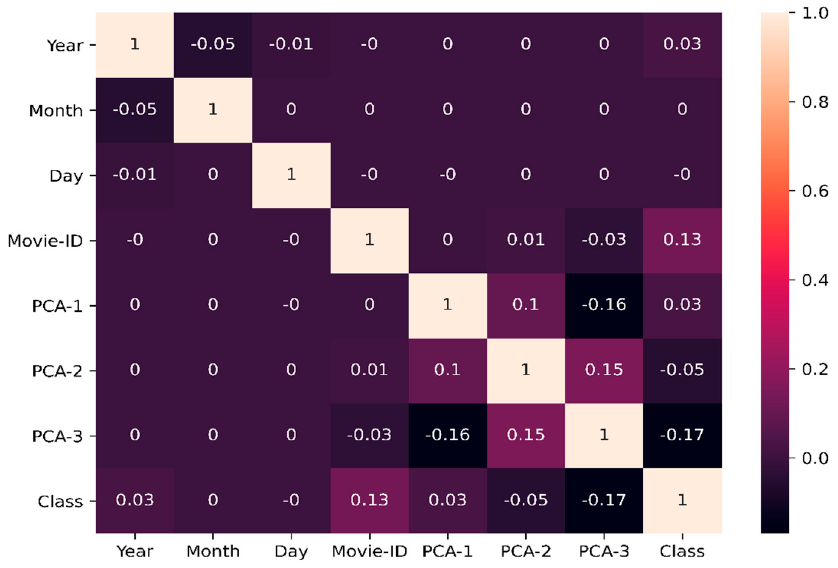
Figure 9. Dataset correlation matrix